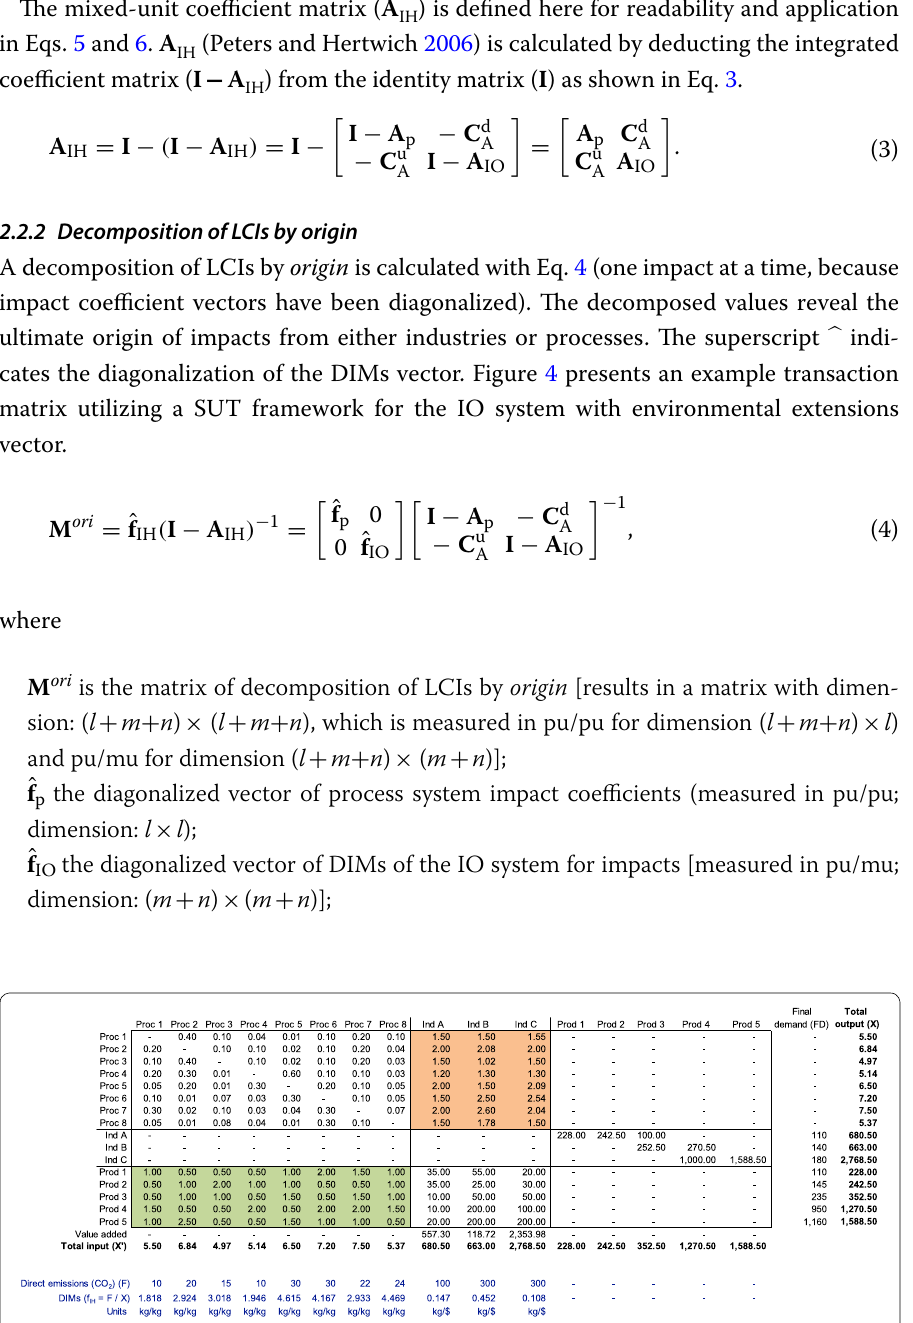
Fig. 4 Example transaction matrix with eight processes, three industries and five product sectors with extensions for greenhouse gas emissions (upstream and downstream cut-off matrices are shaded in green and orange,